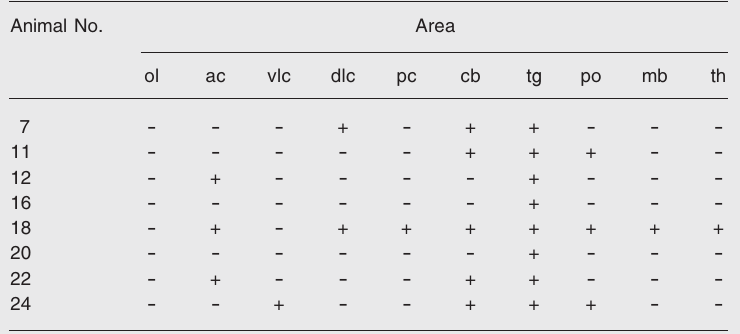
Table 1. Detection of bovine herpesvirus 5 DNA by PCR in brain sections of rabbits 60 days after intranasal inoculation (group A). Animal